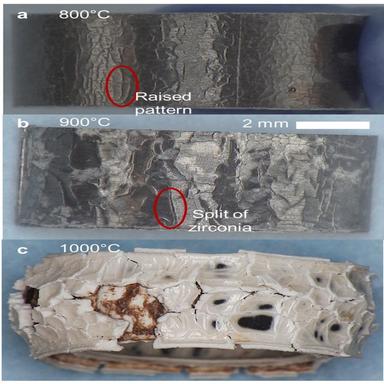
Optical images of uncoated samples as stabile zirconia fails through oxygen penetration, onset of breakaway oxidation with a tortoise pattern, and full breakaway oxidation with barreling and fracture along the tortoise pattern.